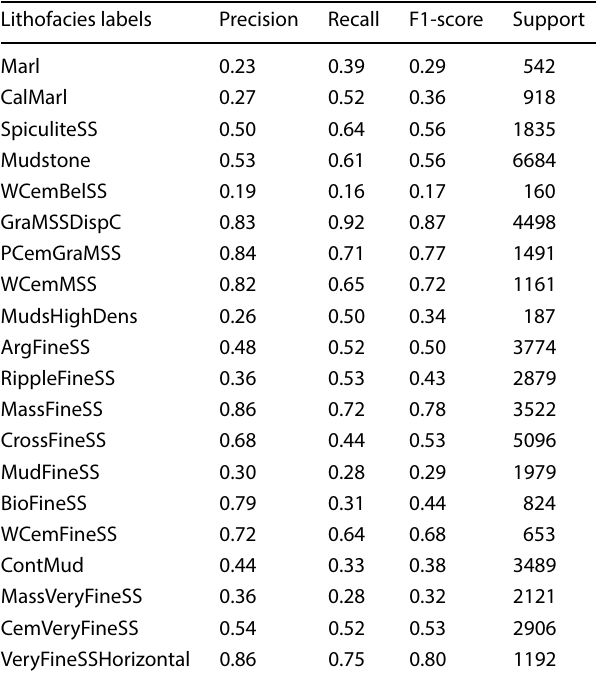
Table 3 Prediction accuracy metrics on the test set using the trained CNN classifier. Support shows the number of predicted samples for each